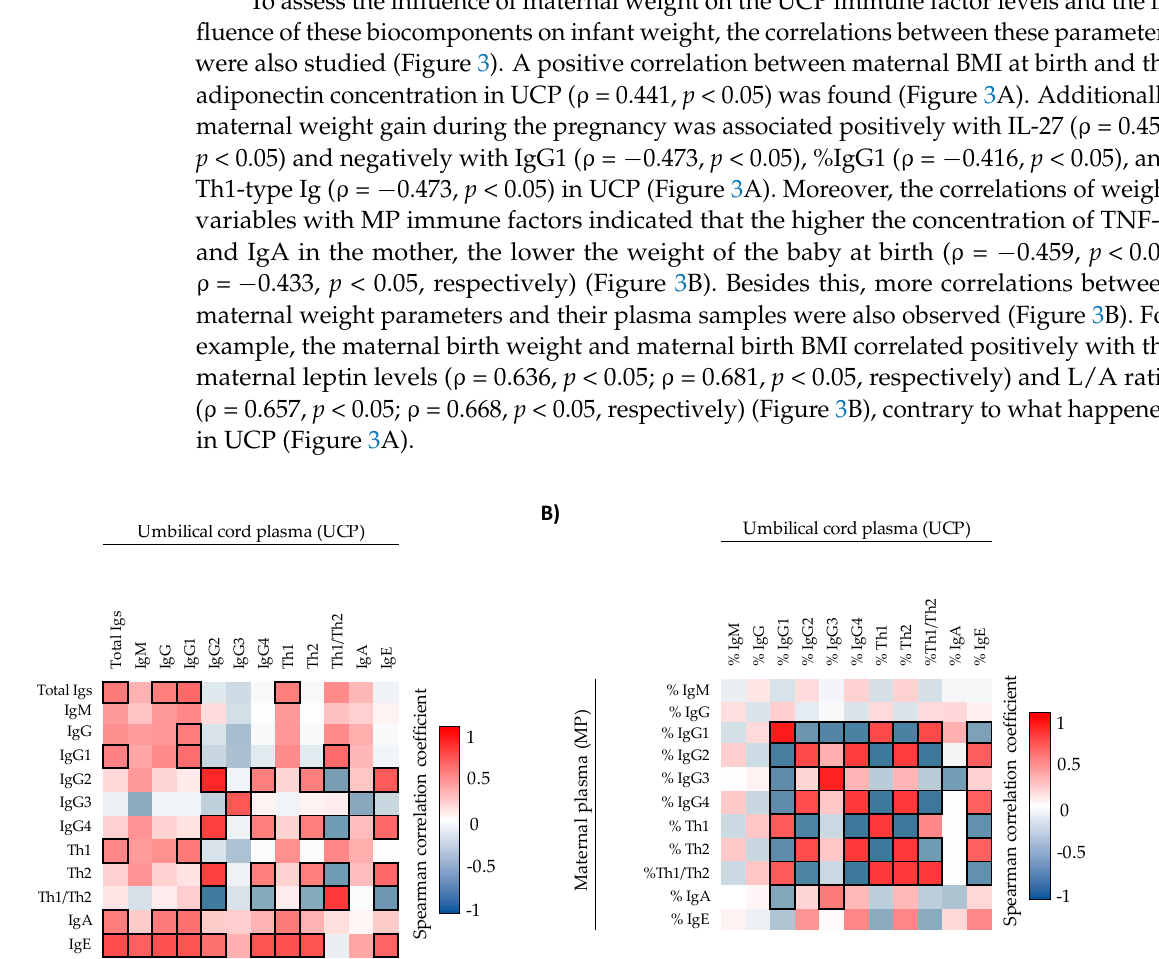
Figure 2. Correlations between the Ig concentrations ( A ) and the Ig relative percentages ( B ) present in umbilical cord plasma and maternal plasma ( n = 17). The Spearman correlation coefficient is represented in the heat map following the color in the legend. Bold frames represent correlations with statistical significance ( p < 0.05). MP, maternal plasma; UCP, umbilical cord plasma. IgG1, IgG2, and IgG3 (Igs associated with a Th1 response); IgG4 (Ig associated with a Th2 response) [30,31].